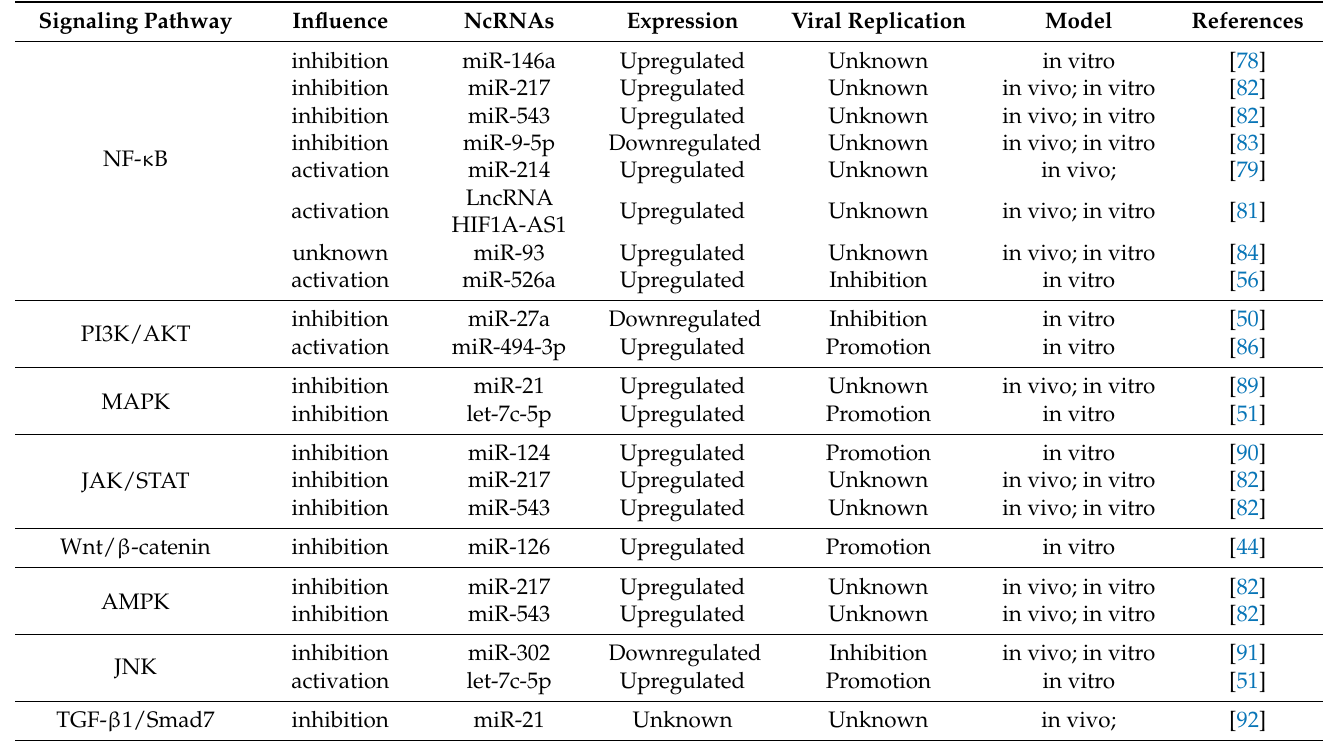
Table 3. The impact of ncRNAs on host signaling pathways following enterovirus infection. Signaling